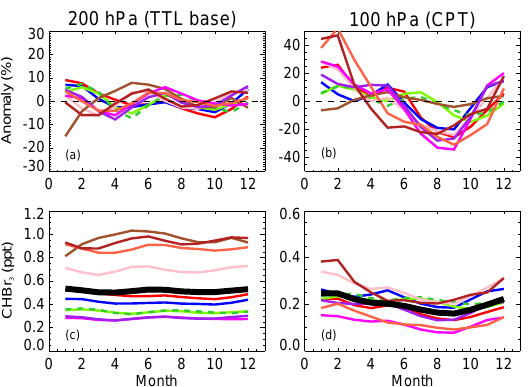
Figure 12. Simulated monthly mean anomalies of CHBr 3 volume mixing ratio (vmr), expressed as a percentage with respect to the annual mean, for (a) 200hPa, the approximate base of the tropical tropopause layer (TTL) and (b) 100hPa, the cold point tropopause (CPT). Panels (c, d) show the CHBr 3 vmr (ppt) at these levels. All panels show tropical ( ± 20 ◦ latitude) averages over the full simula- tion period (1993–2012). See Fig. 3 for legend. The thick black line denotes the multi-model mean.